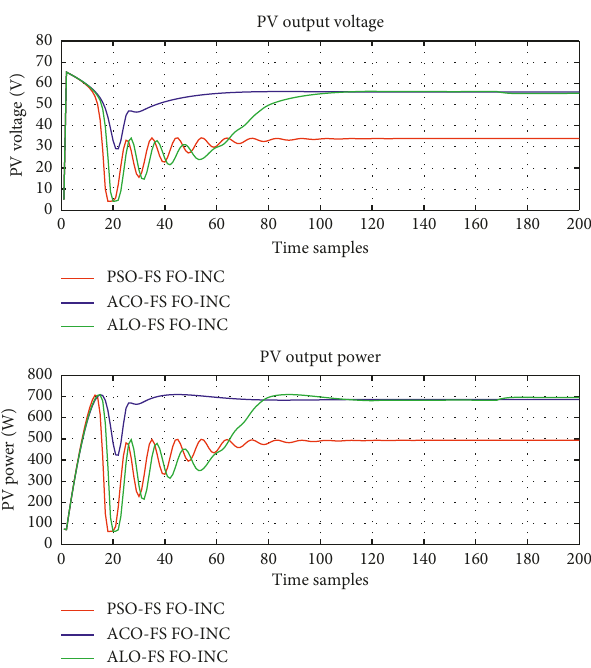
Figure 12: Optimization of fixed FO-INC output